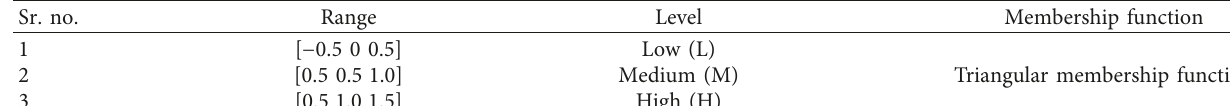
Figure 9: Fuzzy editor in the FIS. Table 7: Fuzzy subsets used for the GFRG.